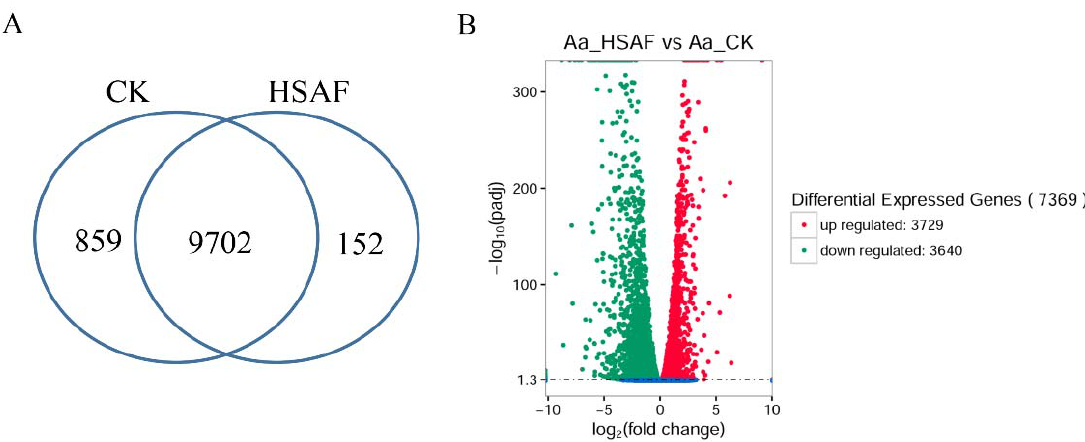
Figure 3. Gene characterization and analysis for differential expressed genes. ( A ) Venn dialog of expressed genes from genome analysis. Venn diagrams depict the numbers of expressed genes in A. alternata strains that were treated by HSAF or adding methanol as a control (CK). The numbers indicate the counts of common or unique expressed genes. ( B ) Volcano Plot of DEGs (differentially expressed genes). Red spots mean up-regulated genes; green indicates down-regulated genes. Green spots indicate down-DEGs, Red spots indicate up-DEGs. X axis represented as fold change of DEGs, and Y axis revealed the adjust p ‐ value ( p ‐ adj).